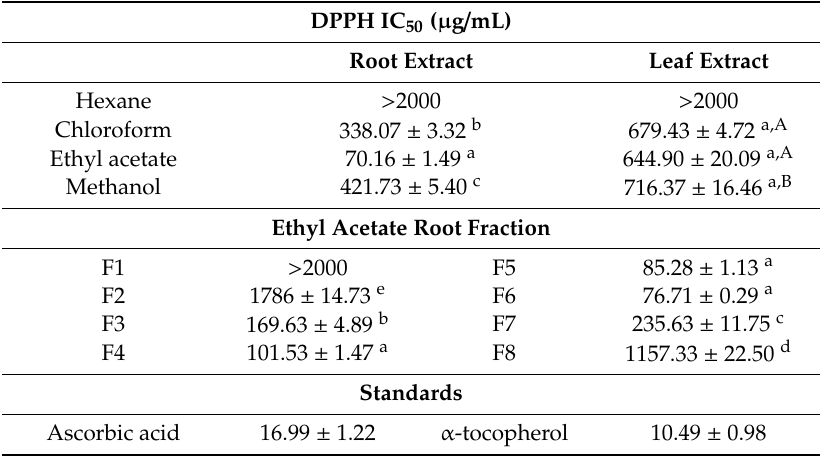
Table 2. DPPH free radical scavenging activity of C. vespertilionis crude extracts, fractions and standards based on the IC 50 values.